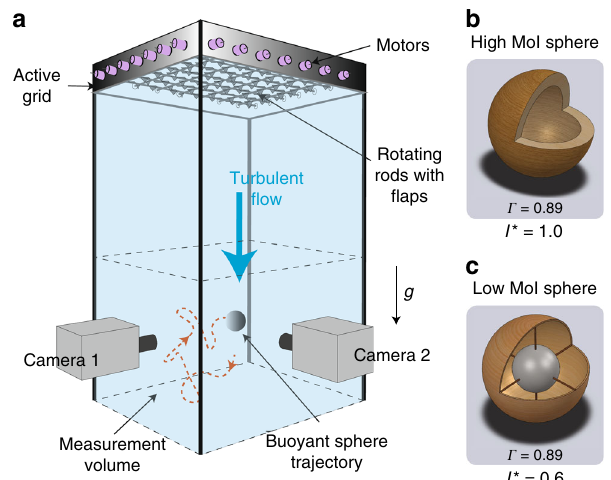
Fig. 1 Experimental facility and spheres used in the present study. a A perspective representation of the measurement section of the Twente Water Tunnel (TWT) with the two camera experimental arrangement for tracking the trajectory and orientation of the buoyant spheres in turbulent fl ow (not to scale). b , c Cut-section schematics of the high and the low moment of inertia (MoI) spheres, respectively. The high MoI sphere is hollow. The low MoI sphere is constructed with a dense metallic core, which is held in the center using thin spokes as shown in c